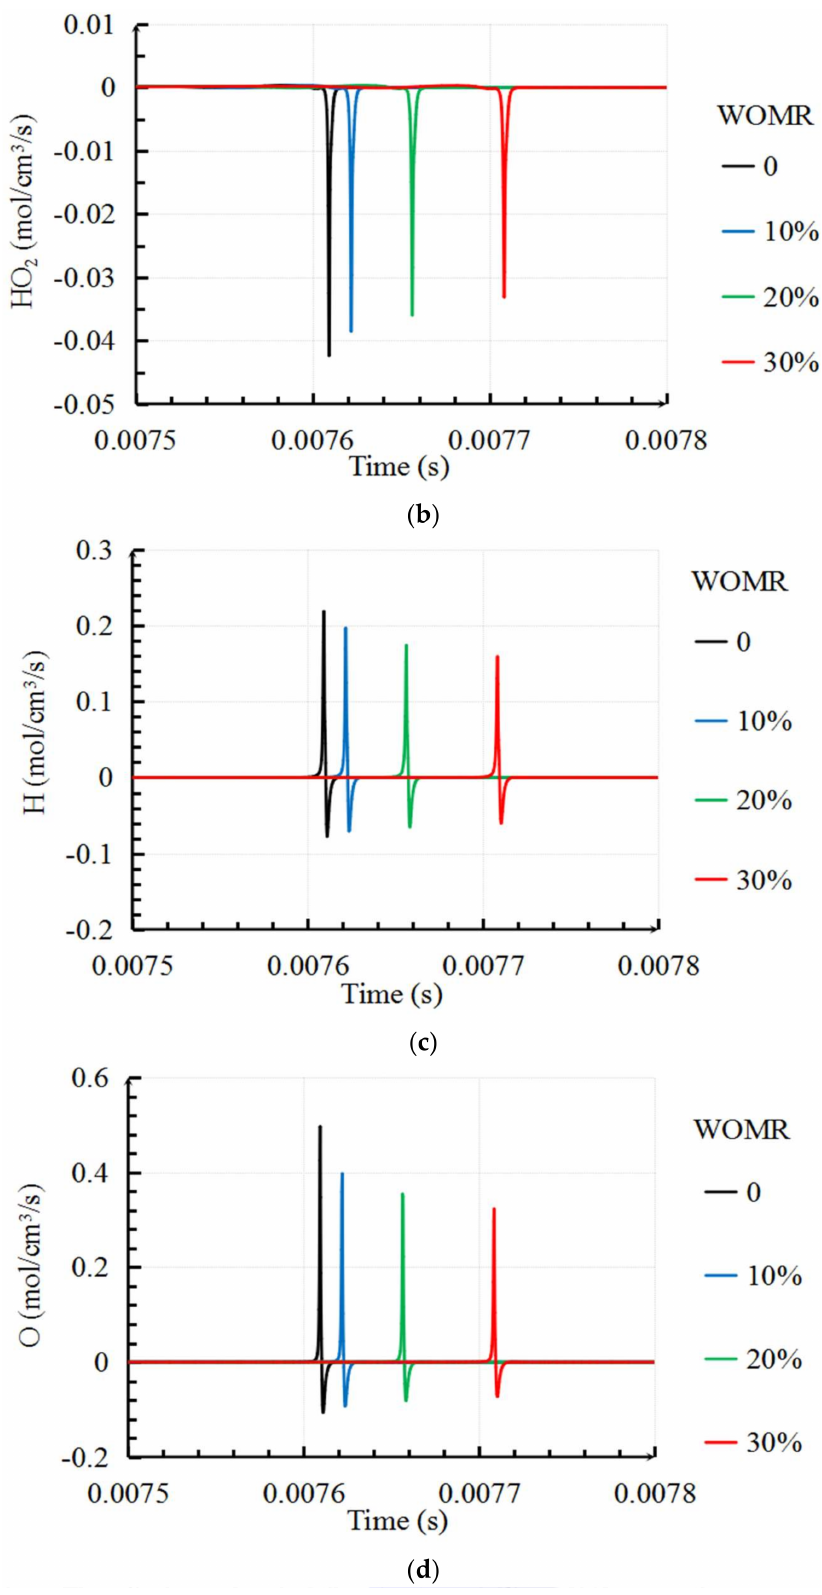
Figure 4. Reaction rate of OH, HO 2 , H and O at different WOMR ( λ = 1). ( a ) Reaction rate of OH; ( b ) Reaction rate of HO 2 ; ( c ) Reaction rate of H; ( d ) Reaction rate of